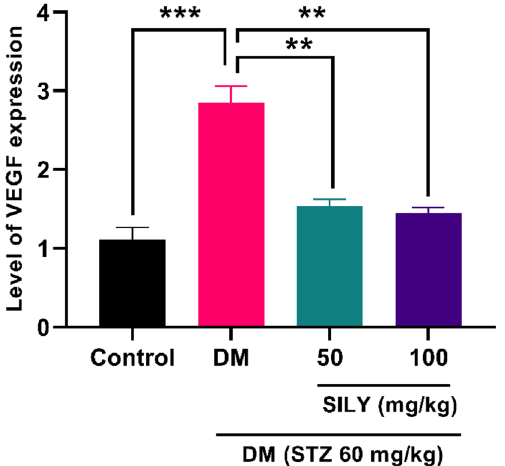
Figure 6. Silymarin attenuates VEGF levels in the retina of diabetic rats. Q-RT-PCR was applied to quantify mRNA. Data are reported as mean ± SD. The differences between groups were compared using one-way ANOVA and Tukey’s post hoc test. Eight animals in each group were utilized for this experiment. ** and *** showing p < 0.01 and p < 0.001, respectively. DM: diabetes mellitus; SILY: silymarin; VEGF: Vascular endothelial growth